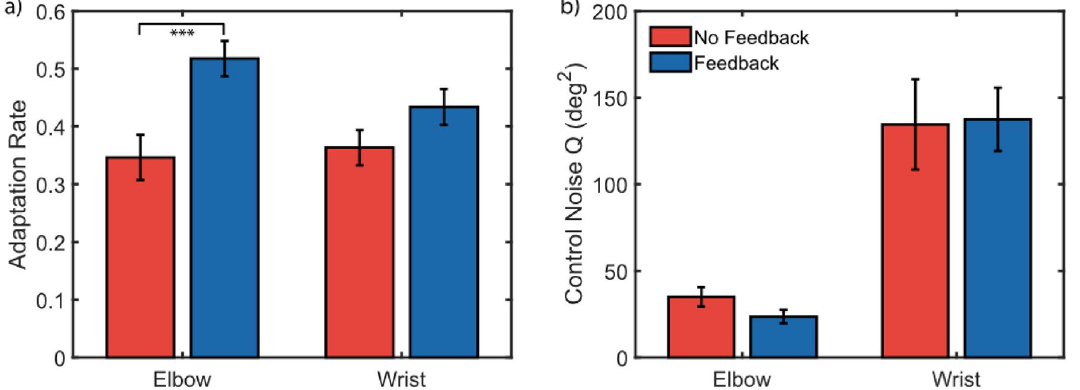
Figure 6. Non-amputee secondary trial-by-trial analysis. A secondary trial-by-trial analysis using stochastic signal processing approach found that ( a ) joint-speed feedback significantly improved adaptation of positional elbow movements, though the improved adaptation of myoelectric wrist movements was not significant, and ( b ) that control noise was significantly higher for the myoelectric controlled wrist than the positional controlled elbow. ***Indicates p <